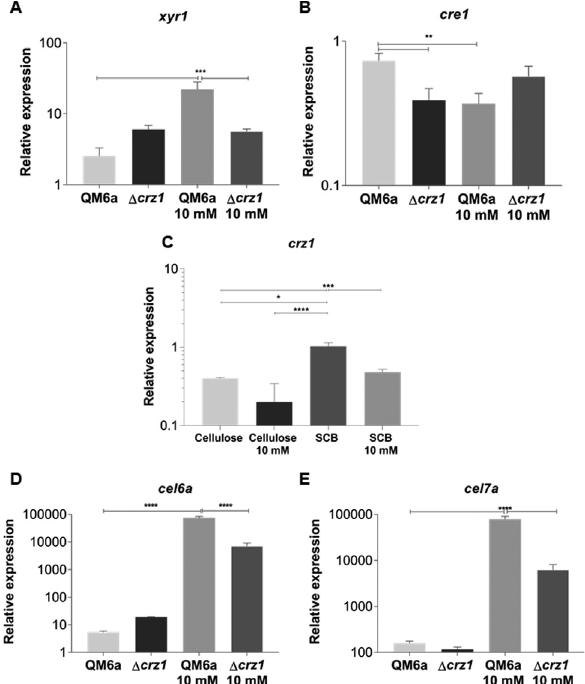
Figure 2 - Analysis of differential expression of the transcription factors XYR1(A),CRE1(B),andCRZ1(C)of T.reesei andofcellobiohydrolases CEL6A (D) and CEL7a (E) from QM6a and (cid:2) crz1 T. reesei strains after 8 h of growing in SCB and SCB supplemented with 10 mM Ca 2+ . CRZ1 ex- pression in the presence of cellulose and the effect caused by calcium on this induction is also shown in panel C. Expression values are represented as log 10 means of three biological replicates with standard deviation nor- malized by glycerol expression levels at the same condition. Statistical significance is represented as asterisks, considering p-value as <0.05 (*), <0.01 (**), <0.001 (***) and p<0.0001